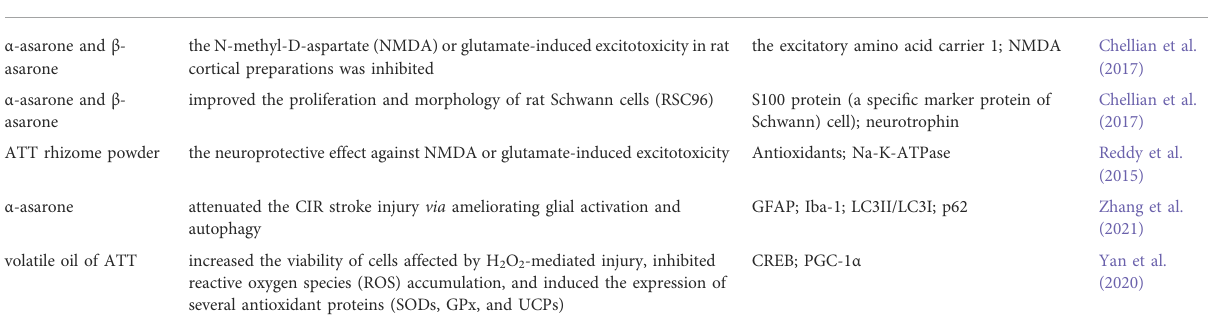
TABLE 3 The neuroprotective targets and mechanisms of